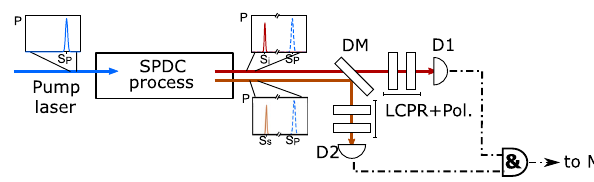
Fig. 1 A high-level schematic of our quantum random number generator. A diode laser is used to pump (with mean photon counts/s, S p ) a spontaneous parametric down-conversion (SPDC) process based on bulk crystals. This results in the production of correlated pairs of photons, which inherit the random arrival time distribution from the pump fi eld (see plotted call-outs). After removal of the pump light, these photon pairs are ef fi ciently separated using a dichroic mirror (DM), and directed to two avalanche photodiode detectors (D1, D2) via two sets of optics implementing a polarization projection. Detectors D1 and D2 have mean photon counts/s, S i and S s , respectively. Digitized electronic signals from the detectors are then combined with an AND gate, and coincident events are accumulated with a microcontroller (MC). For a detailed description of the optical payload, please refer to references 19,28